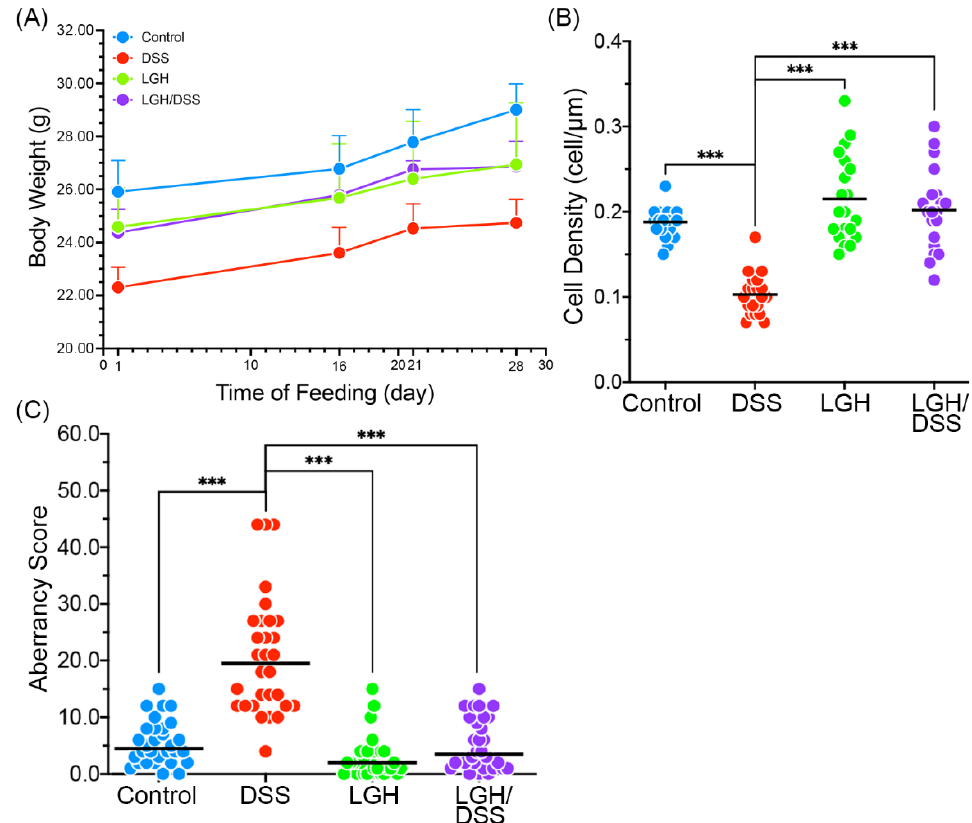
Figure 3. The analysis of body weight and colonic epithelium of mice following LGH administration. ( A ) Body weights of different groups. Error bars represented the positive SD. The averages of the cell density ( B ) and the aberrancy score ( C ) were calculated from 30 sessions for each group. Blue circles, data from the Control group; red circles, data from the DSS group; green circles, data from the LGH group; purple circles, data from the LGH/DSS group. DSS, dextran sodium sulfate; LGH, longish glucomannan hydrolysates. ***, p < 0.001. Table 1. GEE analysis of bodyweight between-groups differences.